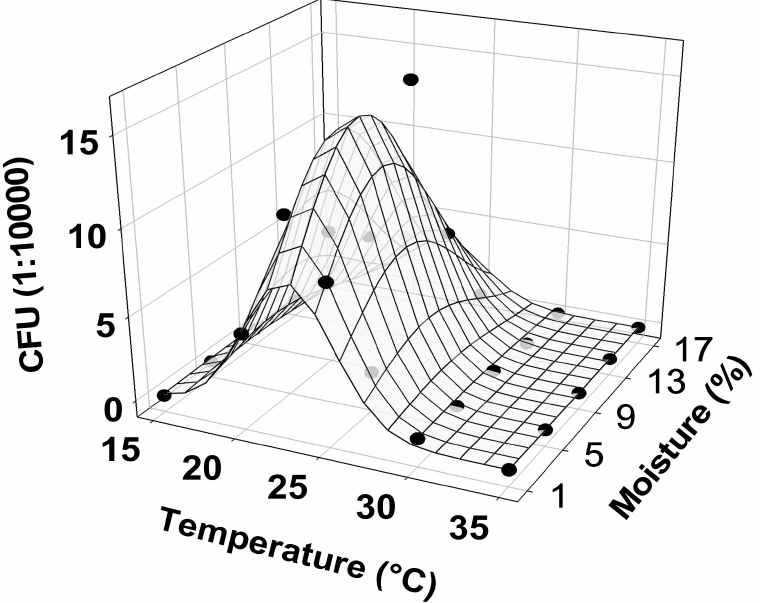
Figure 6. Effects of temperature and moisture on the CFU yield per gram of M. brunneum strain EAMa 01/58-Su microsclerotia. The mesh plots represent the predicted values, and the dots represent actual data.